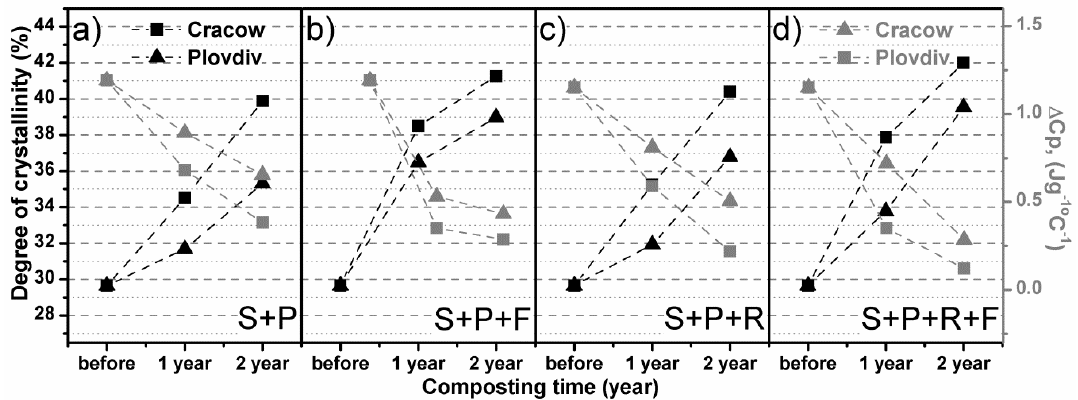
Figure 4. DSC analysis results of semicrystalline PLA spun-bonded mulching nonwovens before and after composting in: ( a ) soil with peat, ( b ) soil with peat covered with foil, ( c ) soil with peat and Radivit ® , ( d ) soil with peat and Radivit ® covered with foil.